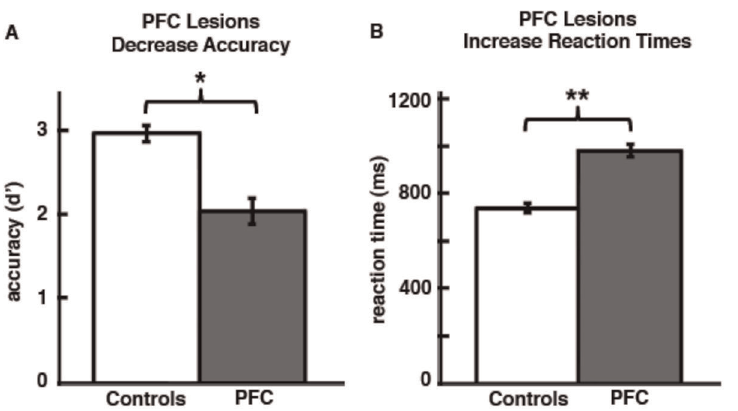
Figure 3. Object-Spatial Behavioral Results. ( A ) Patients showed an overall impairment in object-spatial integration resulting in decreased stimulus sensitivity (d’) across all trials and conditions. ( B ) Similarly, patients showed an overall response impairment resulting in increased reaction times across all trials and conditions. Error bars indicate SEM. (*), significant difference with p=0.0032; (**), significant difference with p , 0.0005.